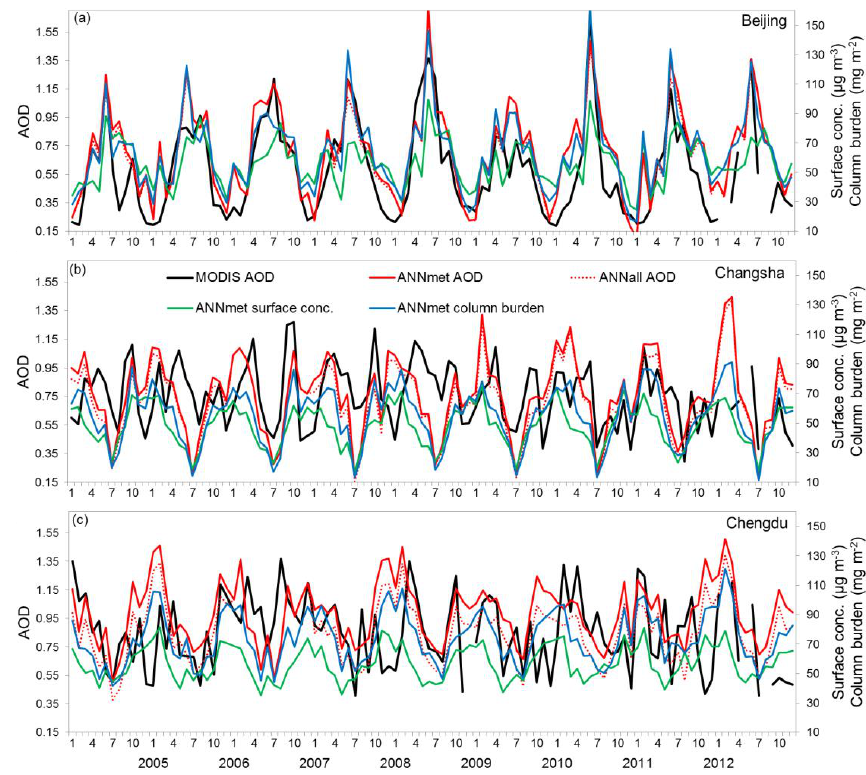
Figure 5. MODIS AOD (black line, left axis), simulated AOD in ANNall (red dotted line, left axis), simulated AOD in ANNmet (red line, left axis), simulated surface-layer PM 2 . 5 concentrations in ANNmet (green line, µgm − 3 , right axis), and simulated column burden of PM 2 . 5 in ANNmet (blue line, mgm − 2 , right axis) over polluted cities of (a) Beijing, (b) Changsha, and (c)